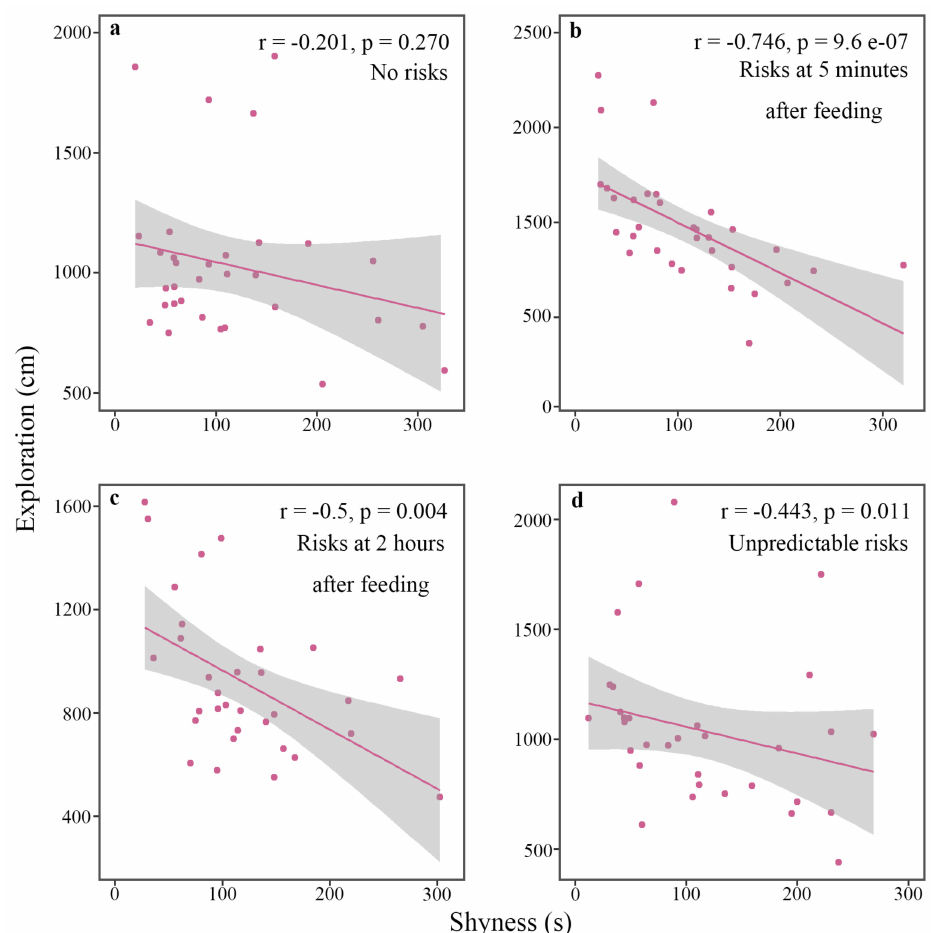
Figure 2. Correlation between shyness and exploration of female mosquitofish reared under no risks ( a ), risks at 5 min after feeding ( b ), risks at 2 h after feeding ( c ), and unpredictable risks ( d ).